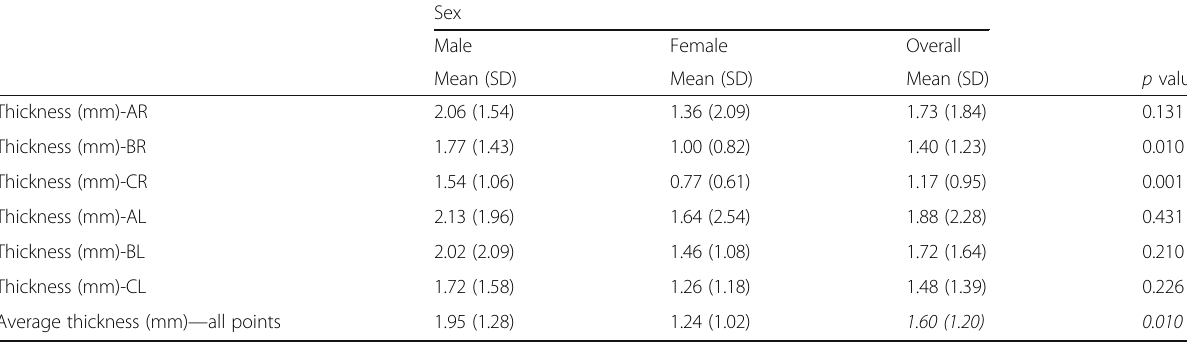
Table 1 Sinuses ’ thickness by gender and